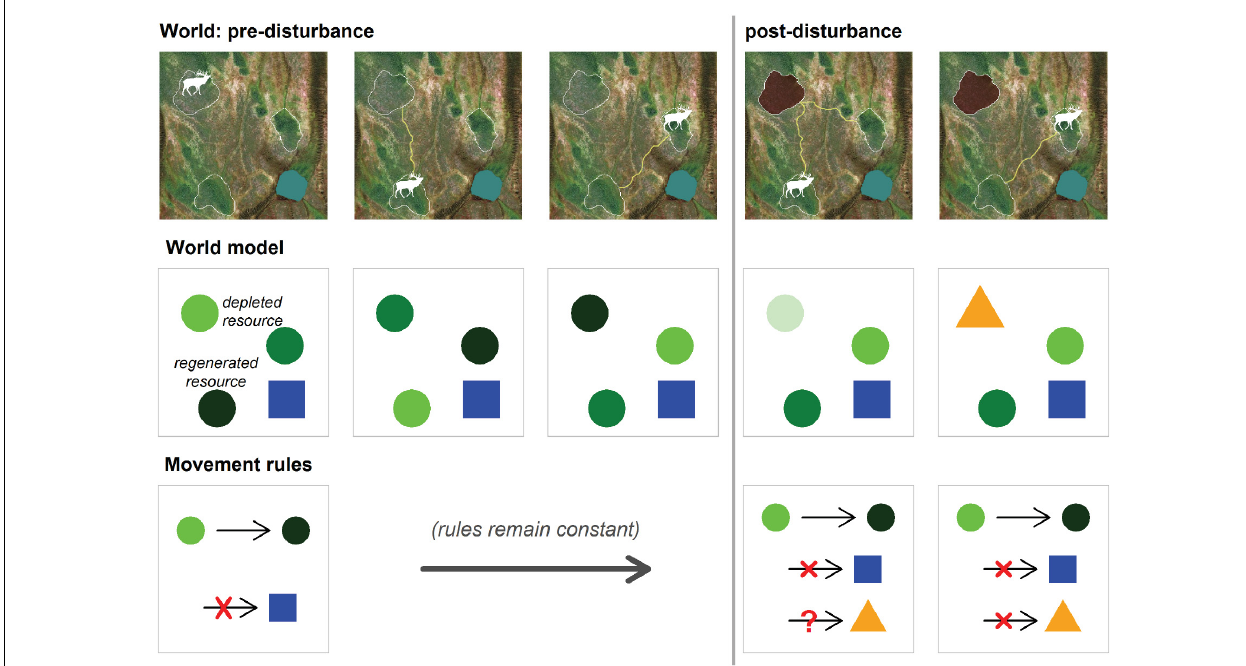
FIGURE 2 | A schematic representation of a forager’s movement rules in a heterogeneous landscape, how a stable set of rules might be applied, and how landscape disturbance could force an update to the movement rules via learning. In a pre-disturbance world (left three columns), the forager (denoted by the white elk symbol) occupies a landscape with three depletable and renewable resource patches and a water body. The “real world” is represented in the top row, with all of its complexity. The second row represents the forager’s model of that world, which distils the complexity to the most relevant information. Shapes indicate different landscape elements, while colors reflect a quantitative score: darker greens are regenerated, paler greens are depleted. The forager has two movement rules in this landscape (bottom row): (1) move from depleted resource patch to a regenerated resource patch and (2) avoid the water body. The pre-disturbance movements rely on a dynamically updated spatial memory, as the forager learns about a changing environment. Post-disturbance, the forager’s world model changes after it gains information about the loss of a potential foraging area, e.g., a new oil well destroys one of the patches. Accordingly, the forager’s world model is refined to include a novel categorical element (orange triangle), with its own avoidance rule for movement (dynamic